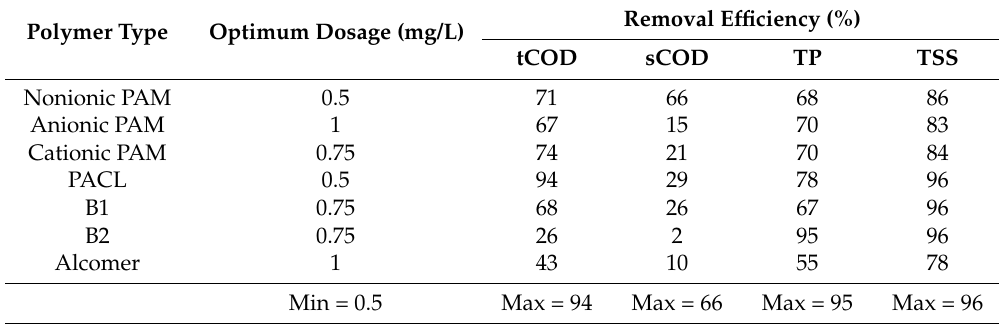
Table 3. Comparison of different polymers.